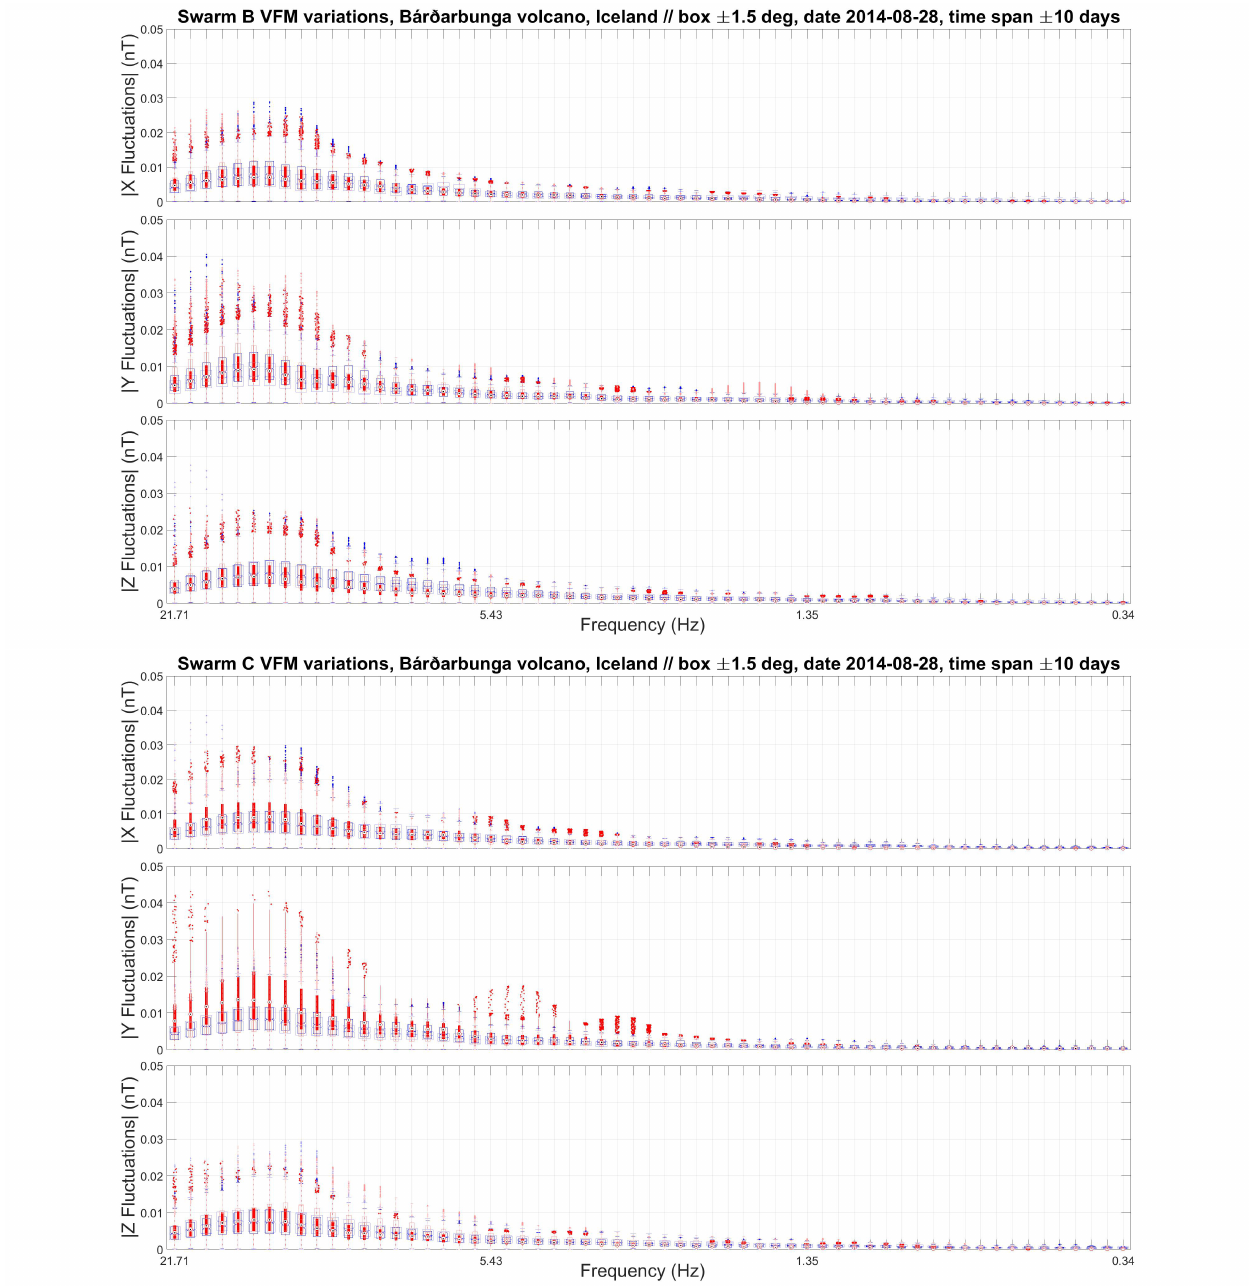
Figure 2. Distribution of Swarm A/B/C ( top / centre / bottom panel) VFM magnetic field fluctuations (box plots) after wavelet transform grouped in individual frequency bands for the August 2014 volcanic event, Bárðarbunga, Iceland. The numbers of pre- or post-crossings for Swarm A/B/C are {3-4/2-2/2-3}. The colour coding {pre/post} is {blue/red} with gradually desaturation {blueish/reddish} for larger ∆ t (interval between crossing and